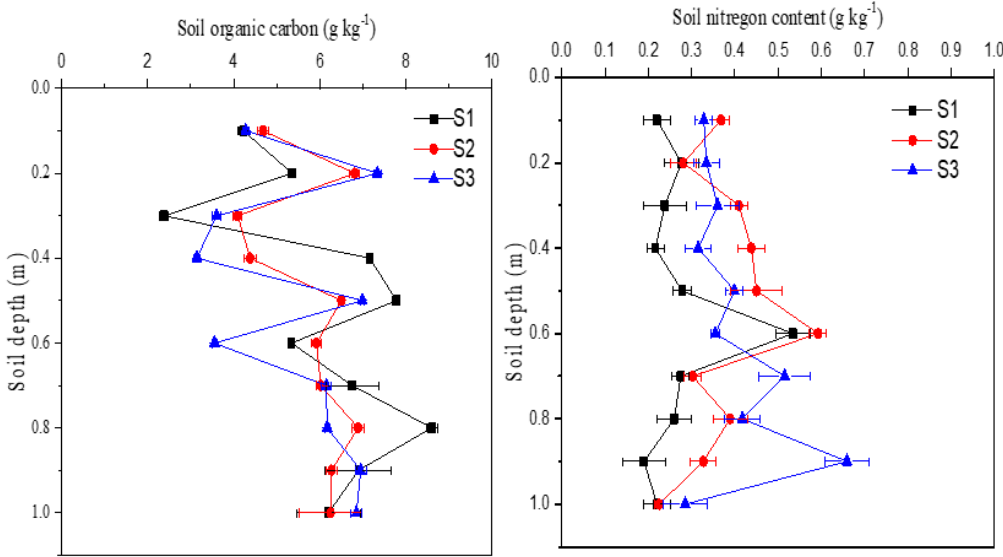
Figure 3. Depth-distributions of TOC and TN in sediment cores near the constructed dam (S1: upper-dam; S2: middle-dam; S3: bottom-dam positions).